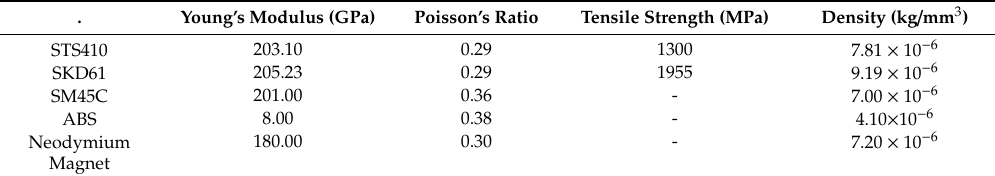
Figure 7. FE model for basic Vibration-based Energy Harvester Table 1. Mechanical